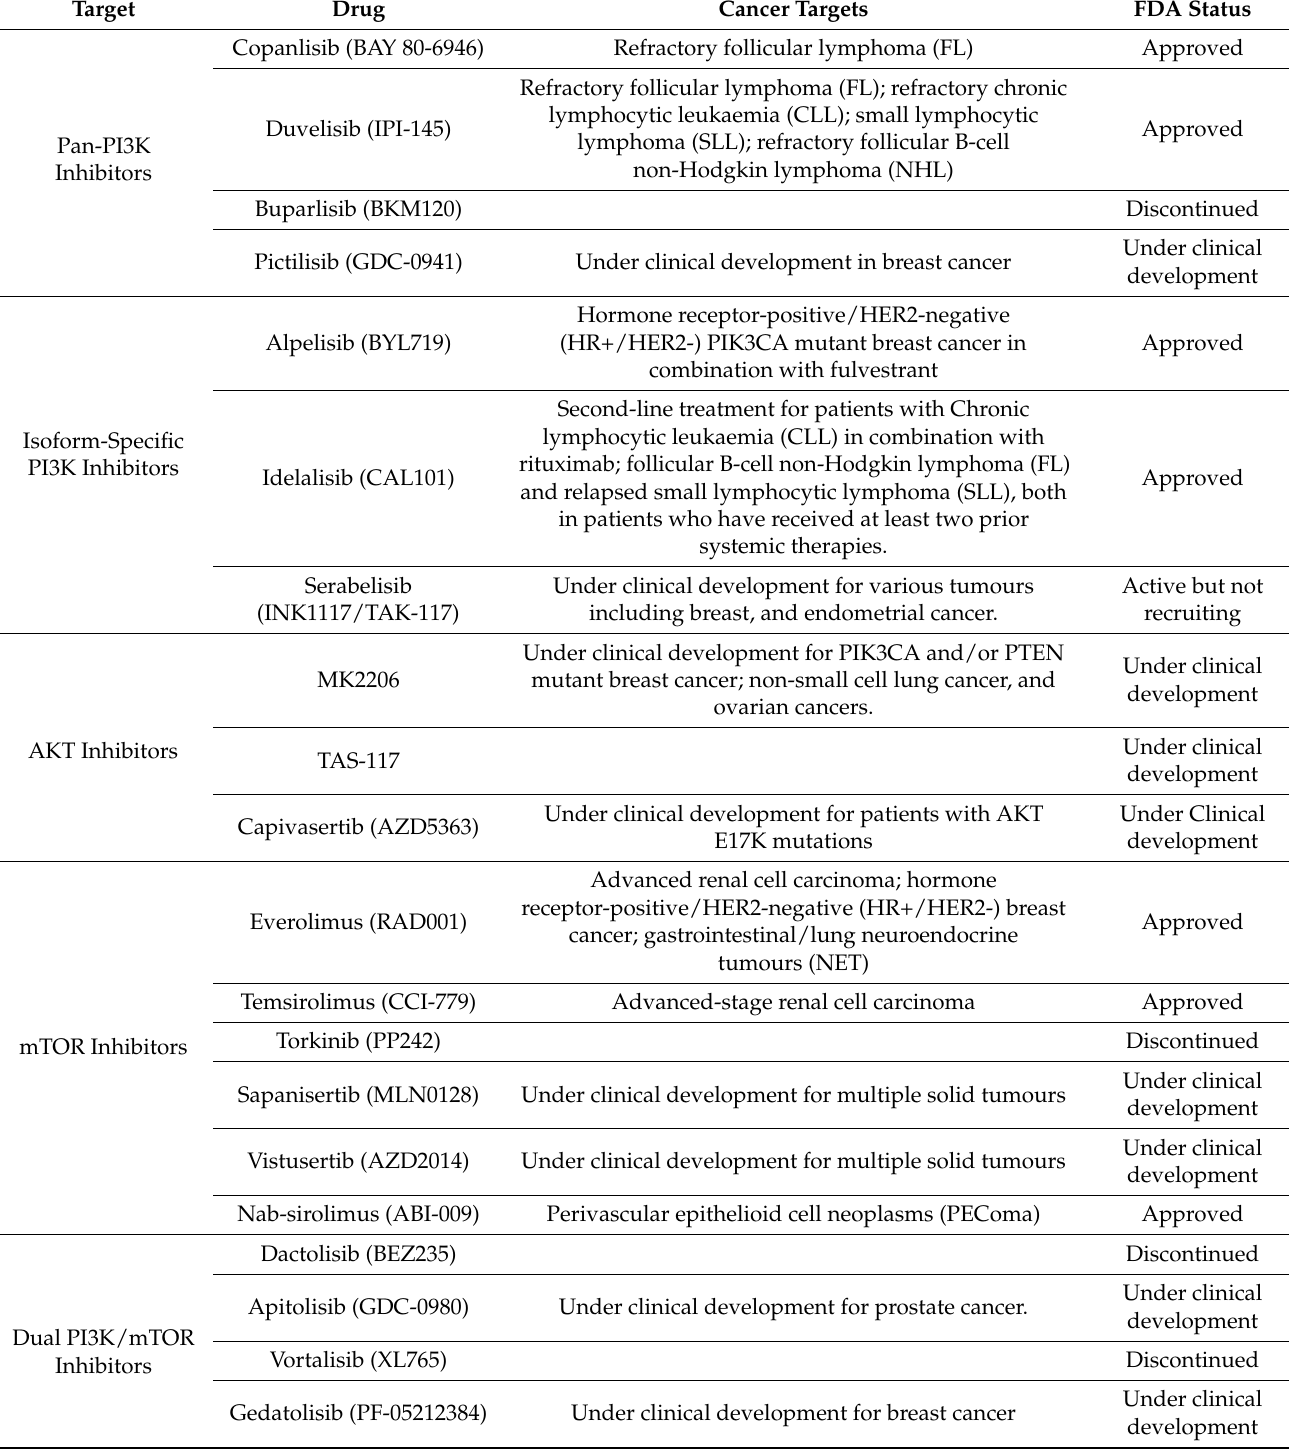
Table 1. Inhibitors of the PI3K signalling pathway. Targeted therapies made specifically for the inhibition of elements of the PI3K signalling pathway. Although there are various targets and specificities for these therapies, only a few have been successful in receiving FDA approval for their effectiveness and patient